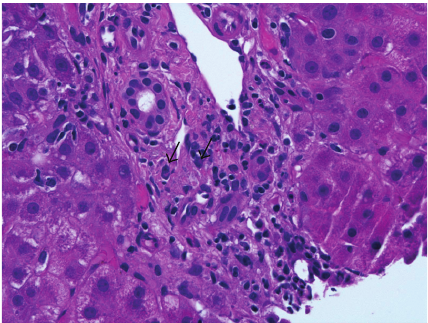
Figure 3: Infiltrating cells in the portal tracts were predominantly lymphocytes admixed with fewer neutrophils, plasma cells (arrows), and rare eosinophils (H&E stain, original magnification